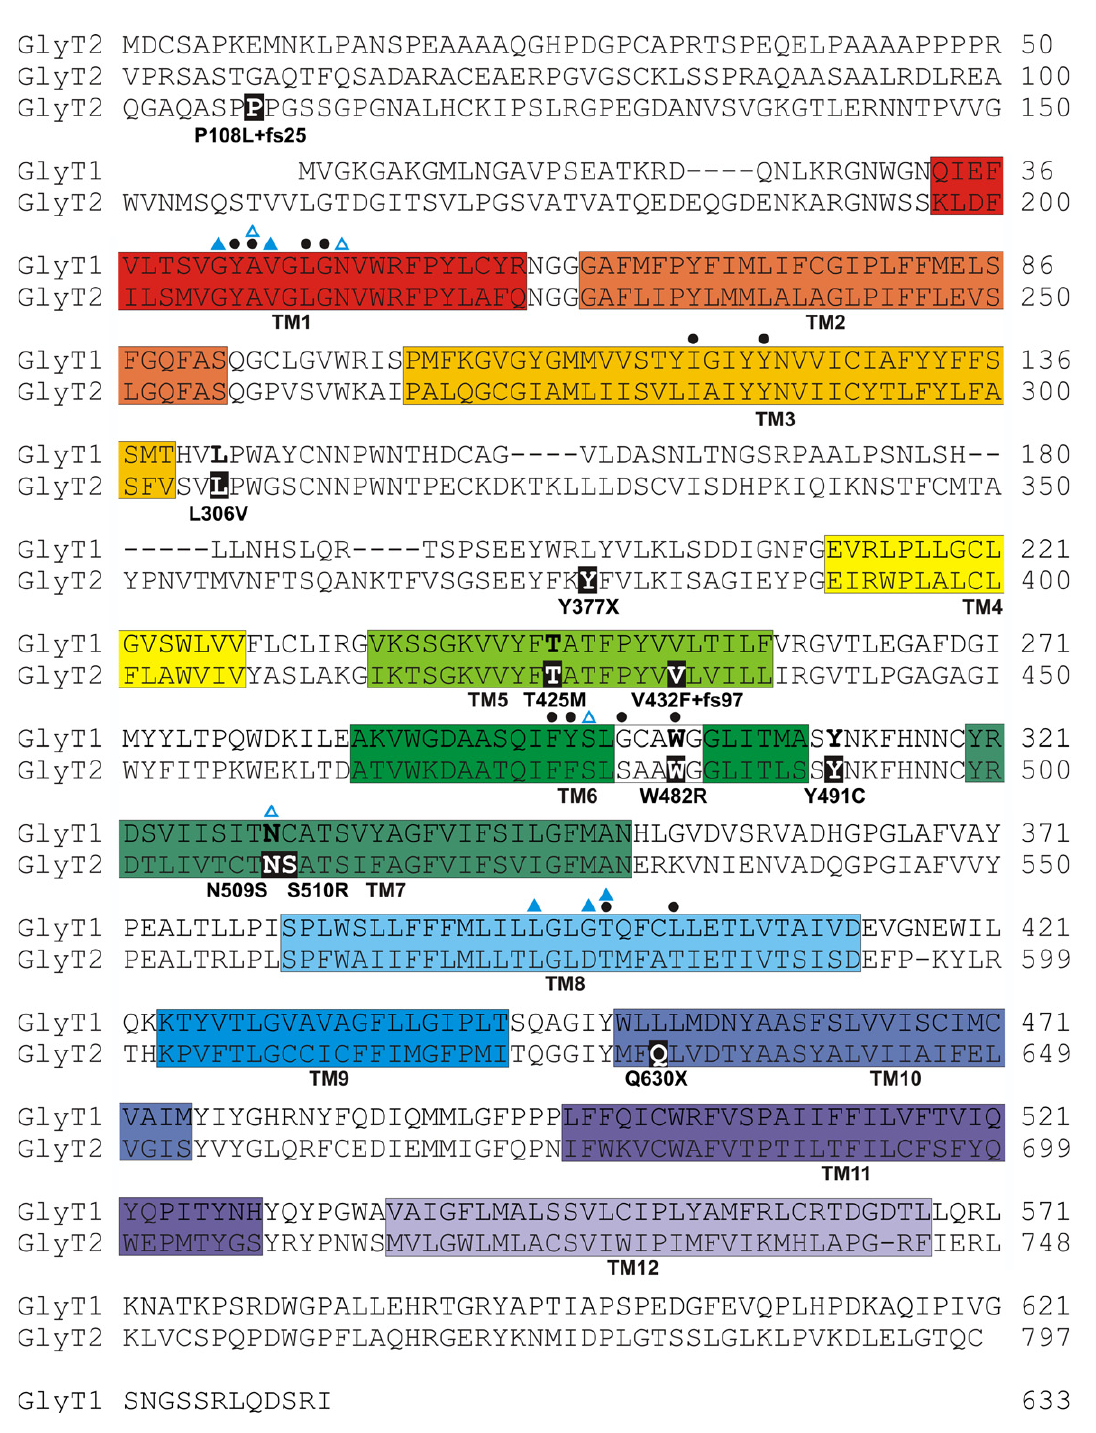
Figure 2. Amino acid sequence of human GlyT1 and GlyT2 indicating the revised positions of putative transmembrane (TM) domains (coloured boxes) based on the structure of the bacterial leucine transporter (LeuT) (Yamashita et al., 2005). Mutations identifi ed in human GlyT2 in hyperekplexia (Rees et al., 2006) are indicated by black boxes. Blue triangles above the sequence indicate residues in hGlyT1 and hGlyT2 that are likely to coordinate Na + ions based on sequence alignments with the bacterial LeuT (Yamashita et al., 2005). However, it is noteworthy that GlyT2 binds three Na + ions, while LeuT and GlyT1 bind two, suggesting that other residues involved in Na + co-ordination remain to be identifi ed in GlyT2. Filled black circles above the sequences indicate residues predicted to be involved in glycine binding. Note that mutations W482R and N509S alter putative glycine and Na + binding residues, respectively.